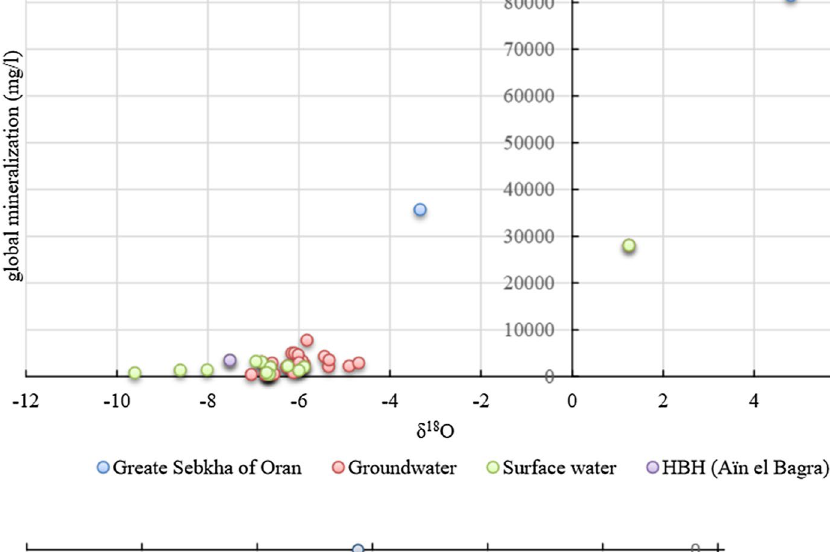
Fig. 5 Correlation δ 13 C -δ 8